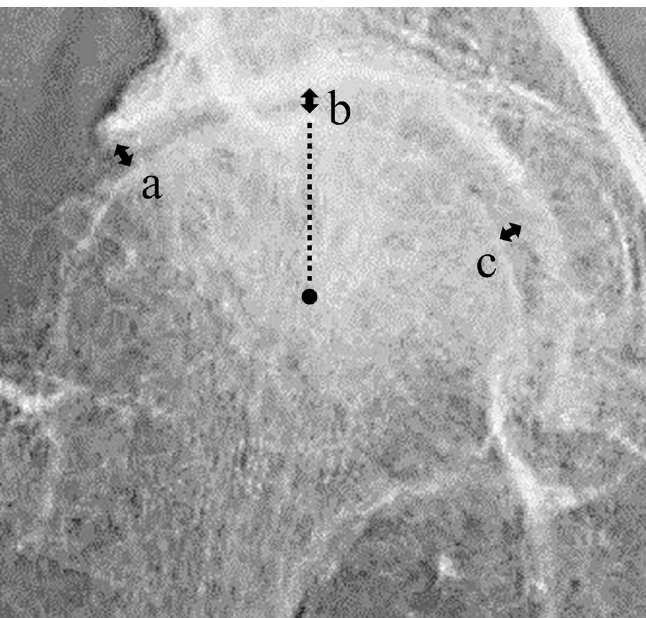
Fig 2. Measurement of the minimum joint space width (JSW). The minimum JSW was measured at three locations: lateral JSW (a), center JSW (b), and medial JSW (c), or at a fourth location if another minimum JSW was observed. Minimum JSW was selected as the smallest